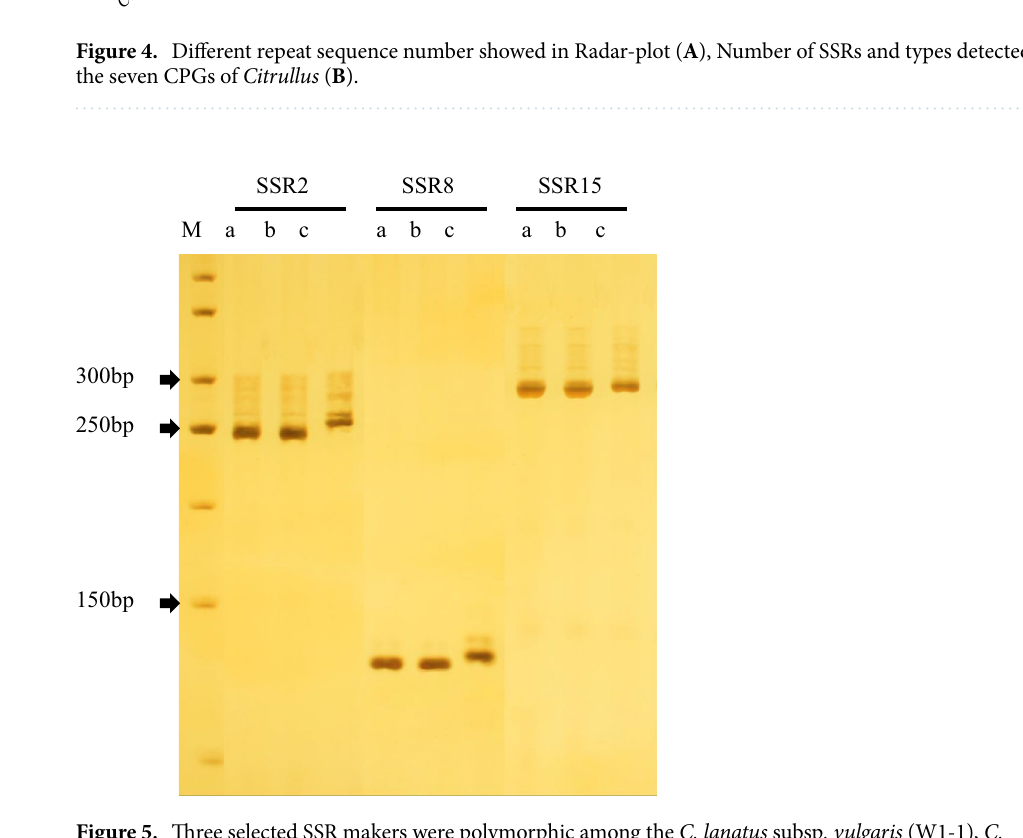
Figure 5. Three selected SSR makers were polymorphic among the C. lanatus subsp . vulgaris (W1-1), C. mucosospermus (PI186490) and C. amarus (PI269341), M: DL500 DNA marker, a: W1-1, b: PI186490, c: